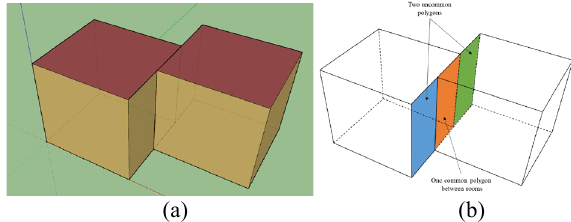
Figure 113. Scenario 4 result. (a) SketchUp visualization; (b) Schema